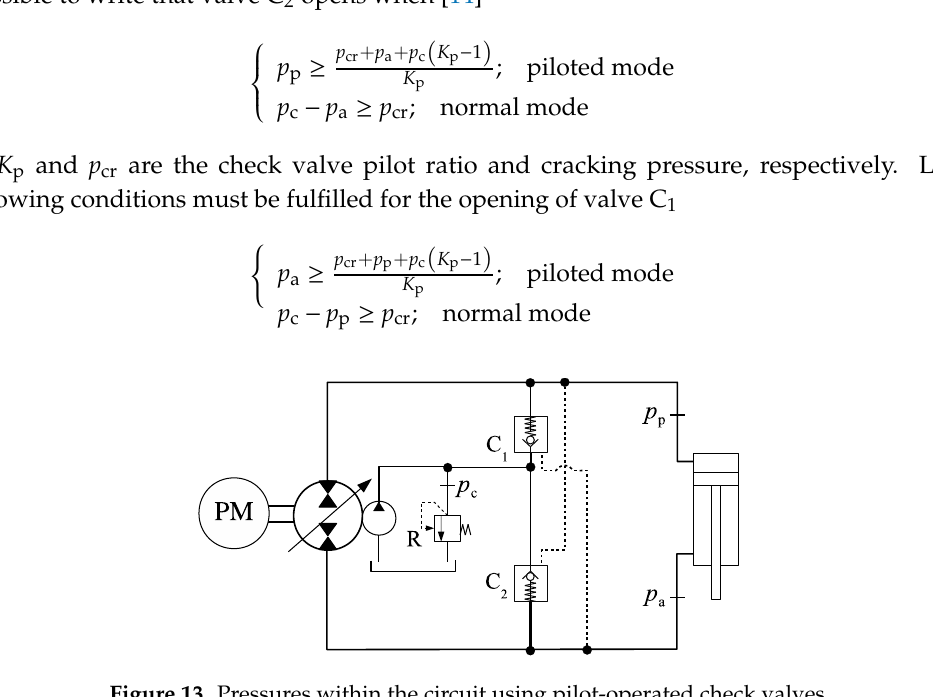
Figure 13. Pressures within the circuit using pilot-operated check valves.